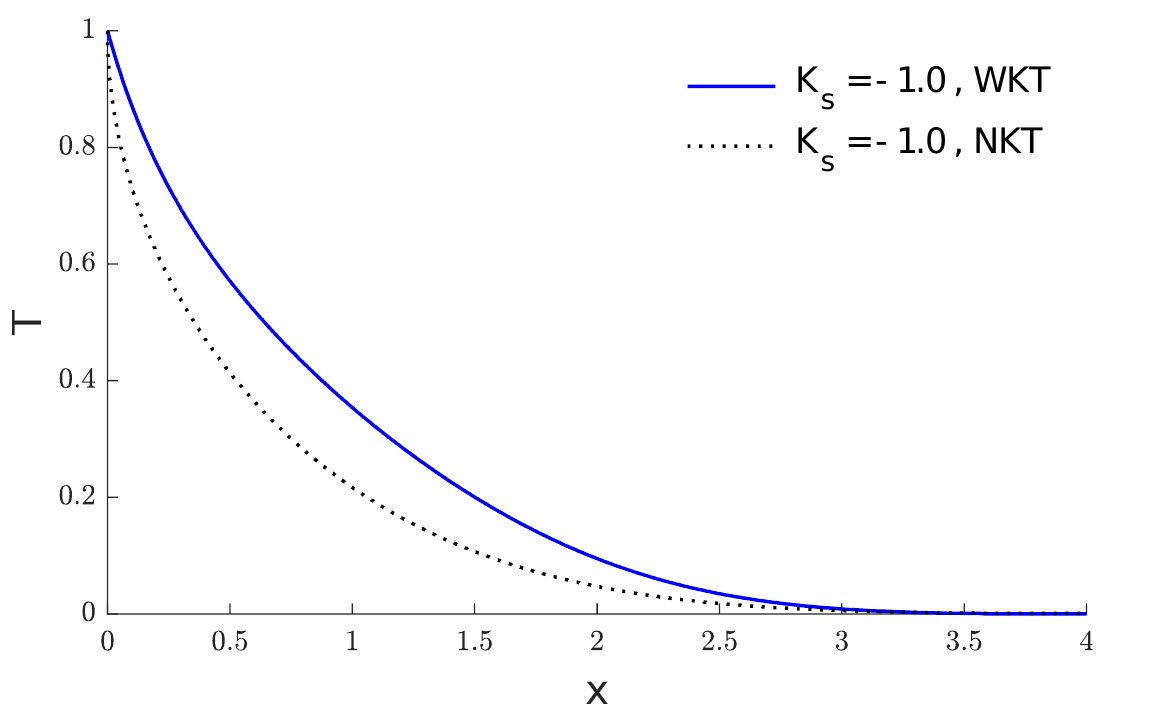
Figure 5. The variations of temperature with and without Kirchhoff transforms when 𝐾 𝑠 = −1 .